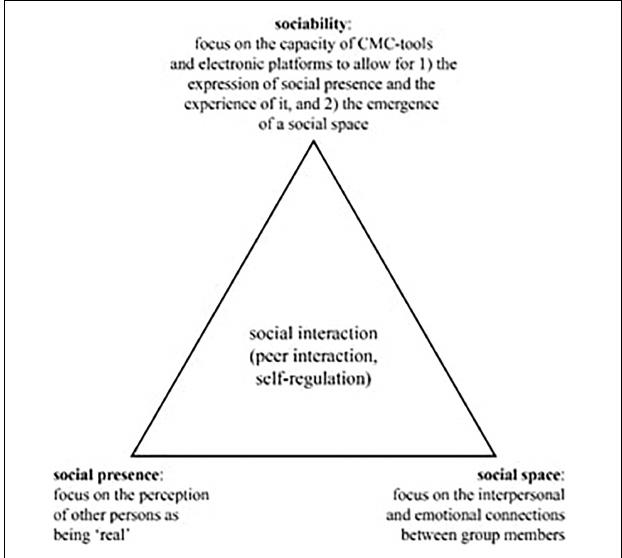
FIGURE 2 | Final thematic